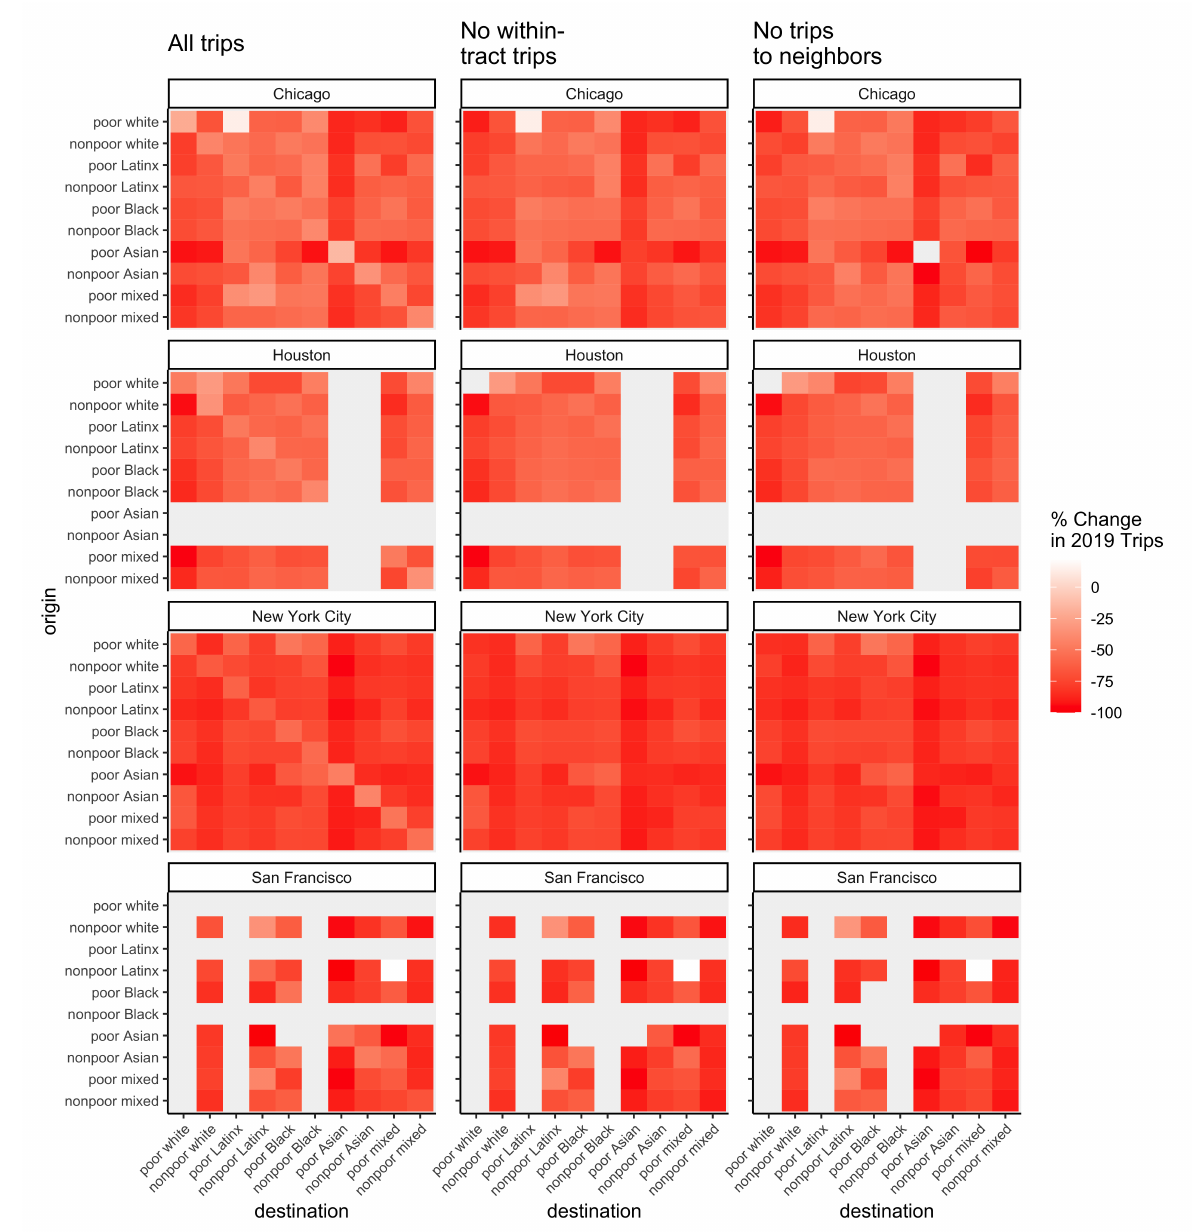
Figure 4: Change in trips between 2019 and 2020 as a percentage of 2019 trips. Each row is a different origin category, and each column is a destination category. Cells are shaded according to their percent change in mobility relative to in 2019 values. The left column includes all trips in our data. The middle column removes trips within the home census tract, and the rightmost column removes trips both from within the home census tract and to immediately adjacent